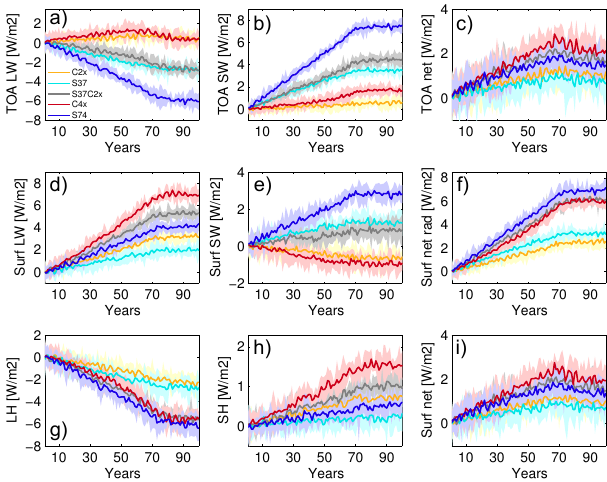
Fig. 2. Global annual mean anomalies of selected components of the energy budget. Averages over five ensemble members are shown and shading extends from the lowest to the largest value obtained by any of the five ensemble members. (a) top of atmosphere long- wave flux, (b) top of atmosphere net shortwave flux, (c) top of atmo- sphere net radiative flux, (d) surface net longwave flux, (e) surface net shortwave flux, (f) surface net radiative flux, (g) latent heat flux, (h) sensible heat flux and (i) surface net radiative and turbulent flux. All fluxes are in Wm − 2 and are defined as positive